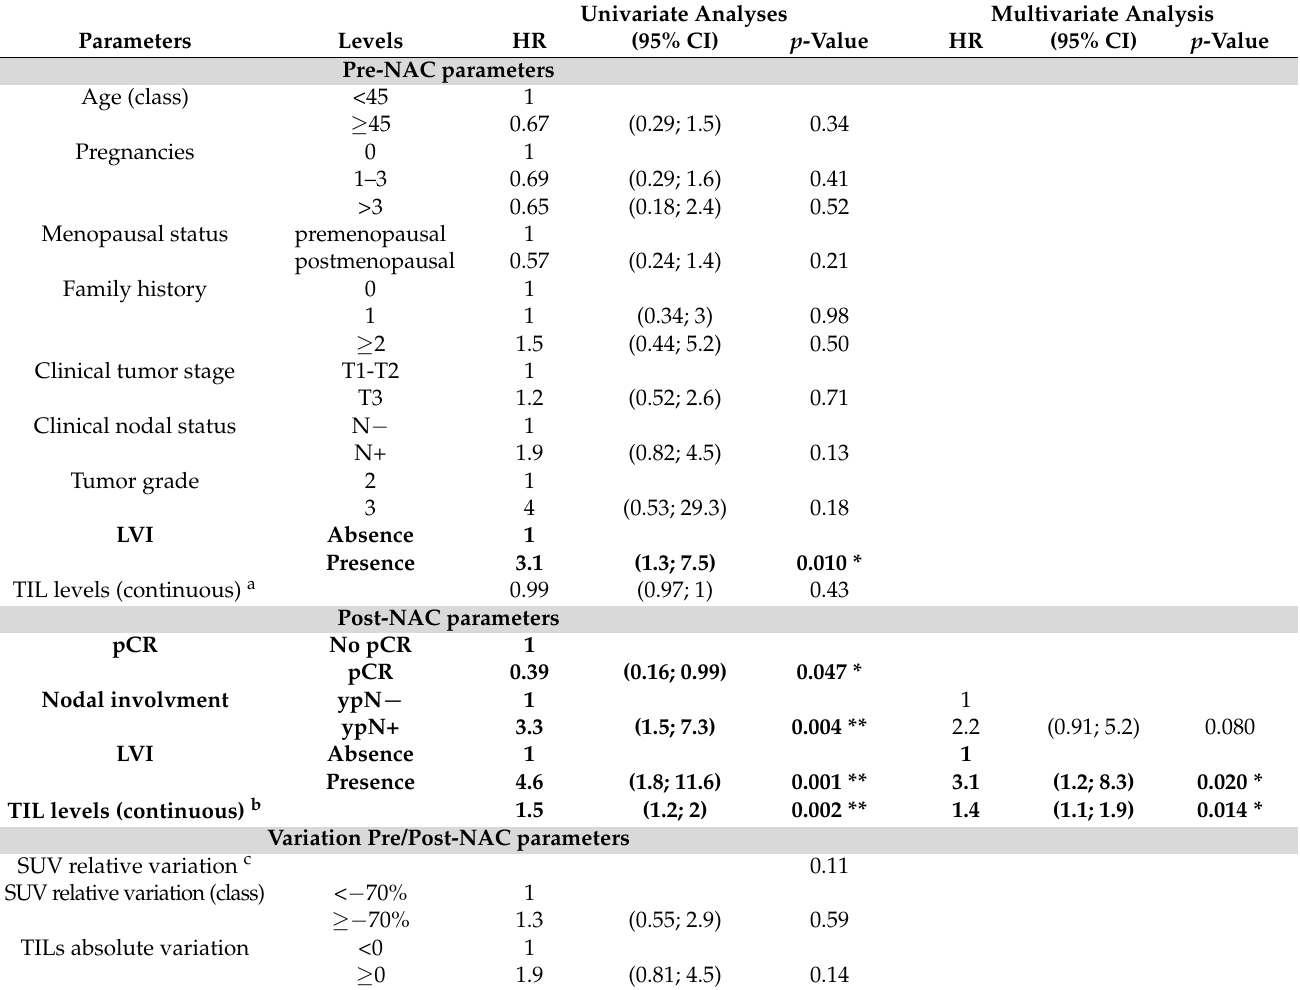
Table 3. Predictive factors associated with relapse-free survival in the whole population. Univariate Analyses Multivariate